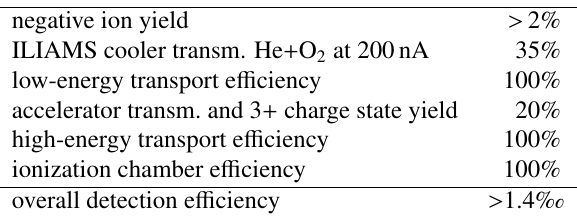
Figure 3. Cumulative negative ion yield of HfF  sputter time for targets filled with powders of HfF 4 , Ag and PbF 2 mixed in three di ↵ erent weight ratios. Ions were collected as 180 HfF  in a Faraday cup. Three sputter targets of each sample 5 material were